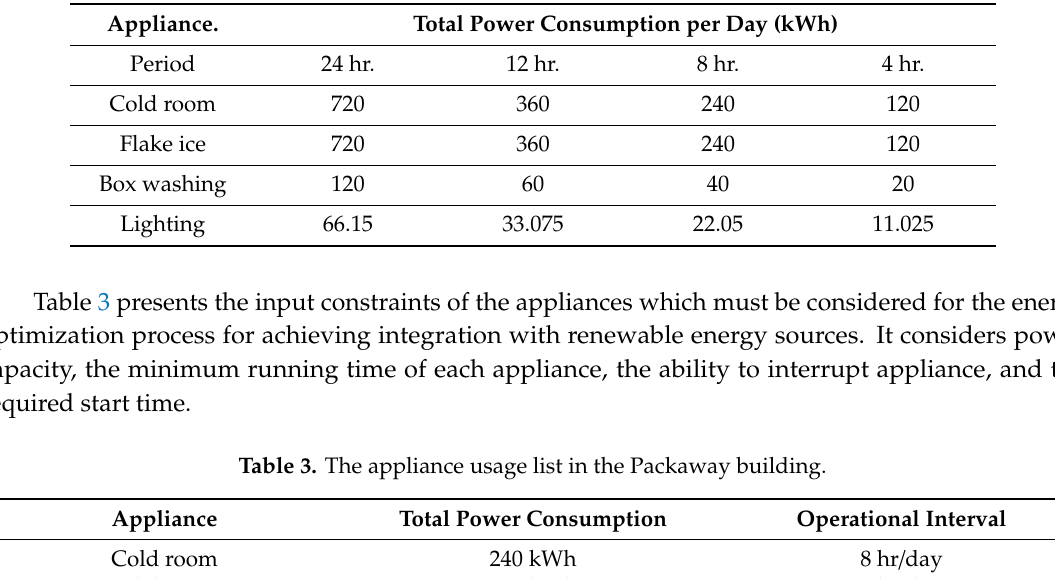
Table 2. Energy consumption per appliance with operation schedules. Appliance.